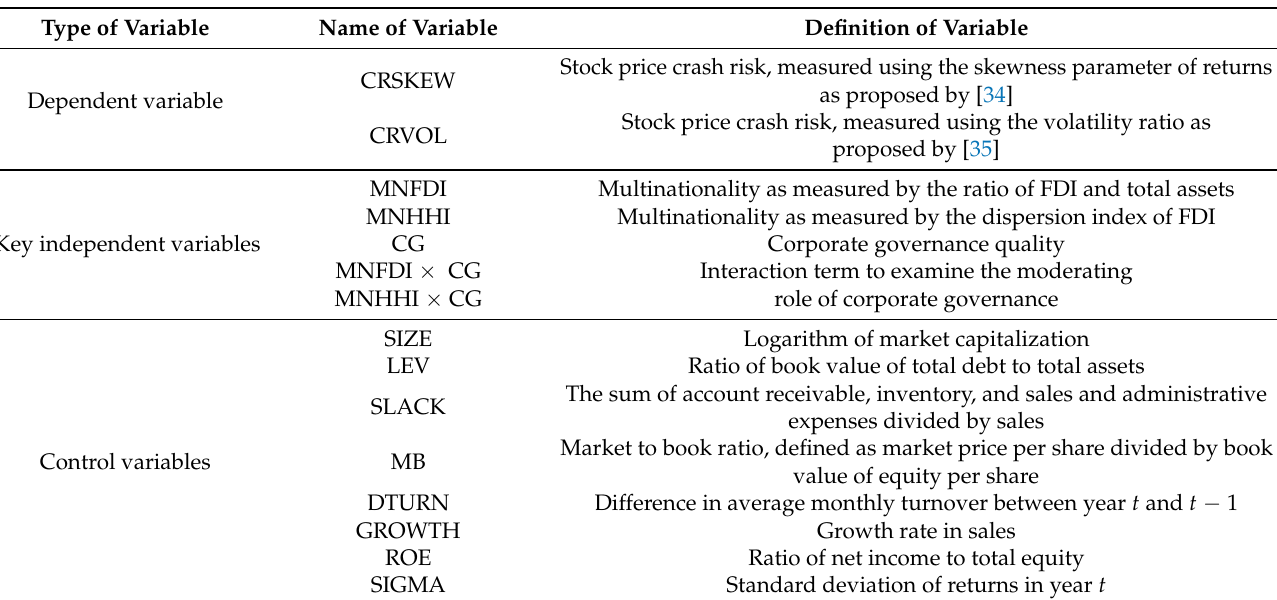
Table 1. List of